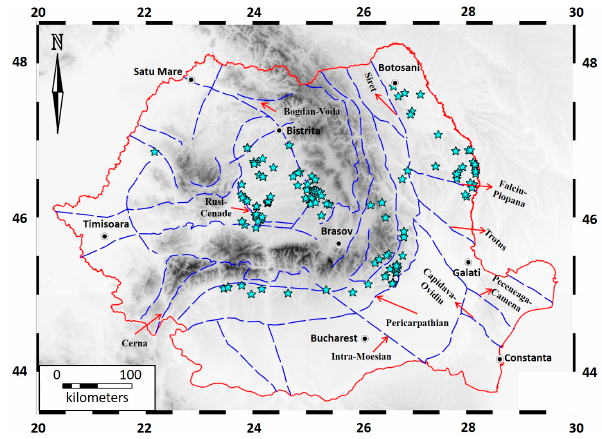
Figure 4. Distribution of active and inactive seeps included in the HYSED-RO database in relation to major faults (blue dashed lines). Tectonics after [48,49,54].